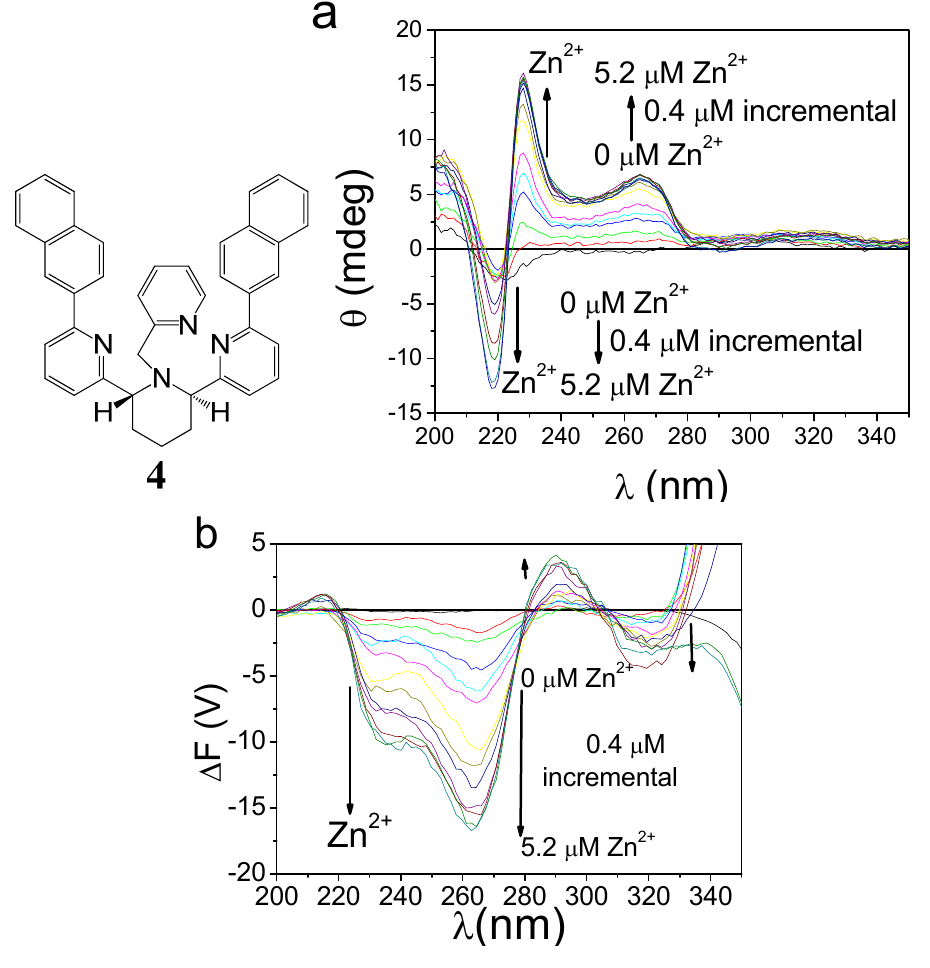
Figure 10. Spectral responses (a, CD; b, CPE) of 4.8  M (R,R)- 4 to 0–5.2  M Zn(II) in acetonitrile [57]. Reproduced by permission of the American Chemical